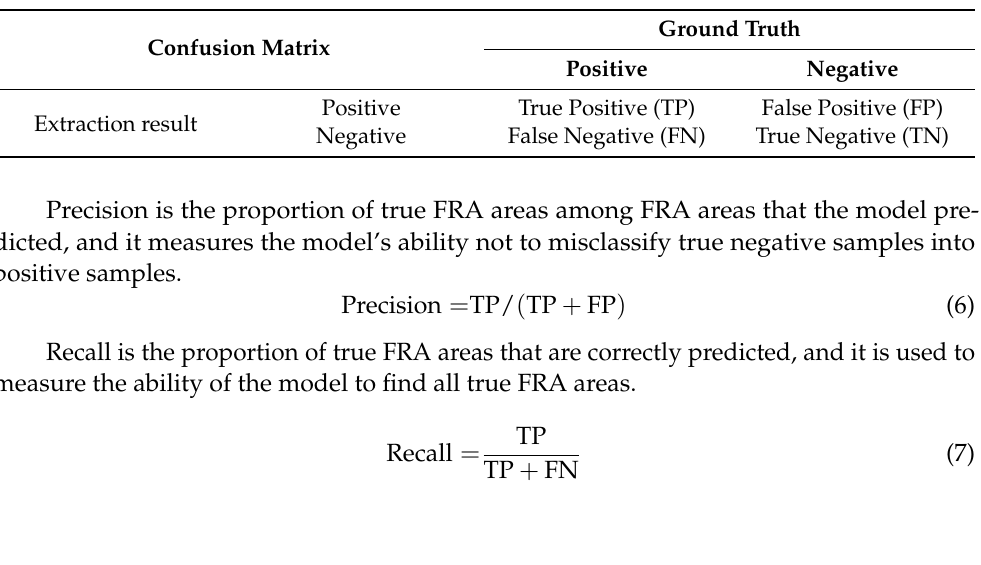
Table 2. The confusion matrix of the experiment